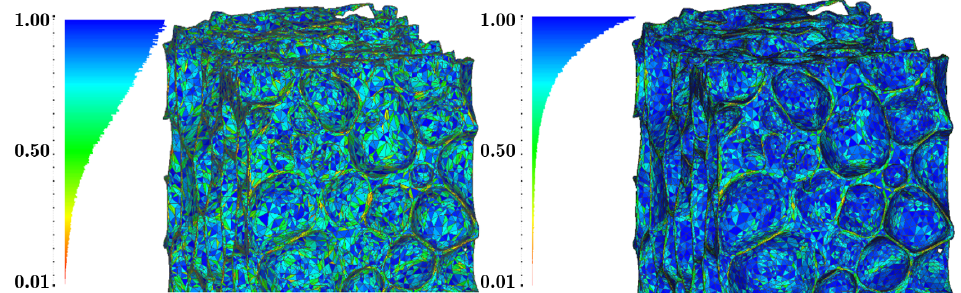
Figure 7. Comparison of surface quality before ( left ) and after smoothing ( right ) for the closed-cell foam specimen. Histograms bars are adjusted to a max